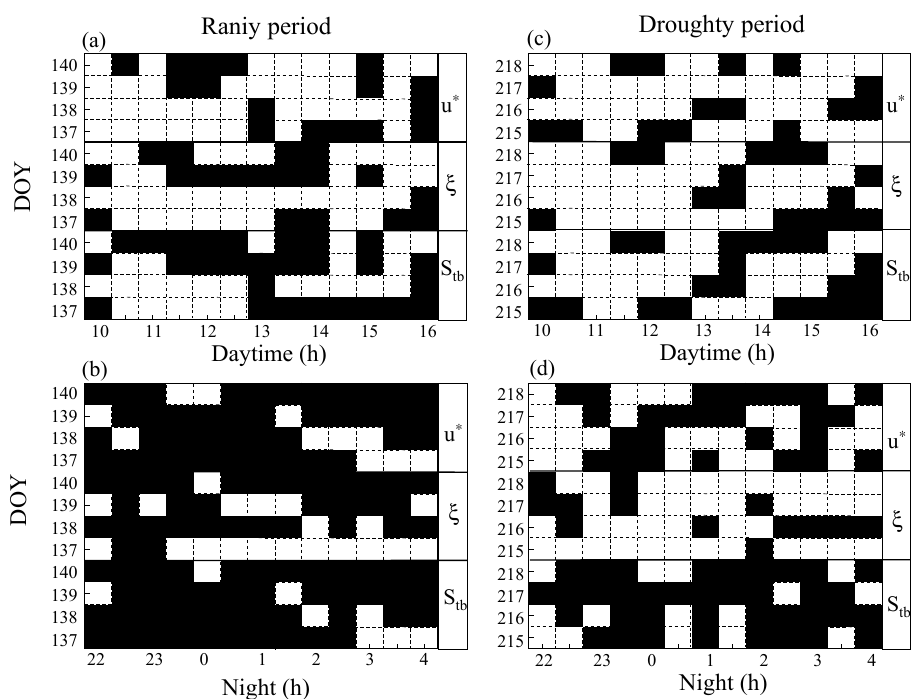
Figure 5. Binary matrix of half hourly friction velocity (u*), atmospheric stability ( ξ ), and atmospheric conditions (S tb ) as determined by the two stability indicators during the daytime (10:00–16:00) and overnight (22:00–4:00) for the typical rainy and drought periods. Black areas show time periods under stable conditions (u* < 0.4 m s − 1 , ξ > 0.1). ( a , b ) are results during daytime and overnight for the rainy period, ( c , d ) are results during daytime and overnight for the droughty period.